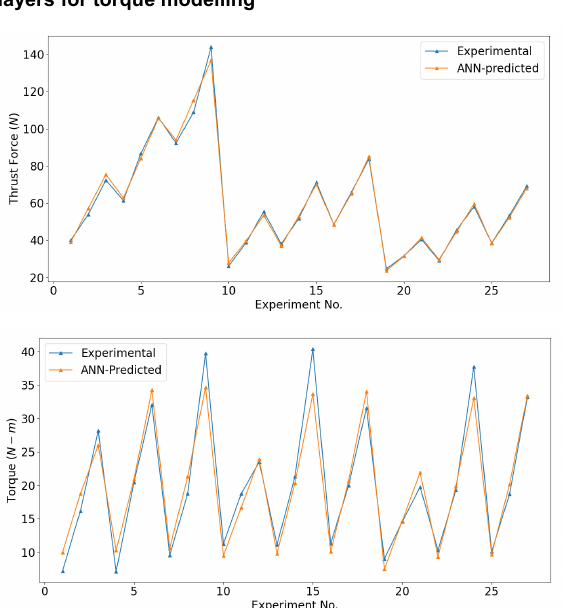
Figure 10. Comparison of experimental and ANN-predicted values of